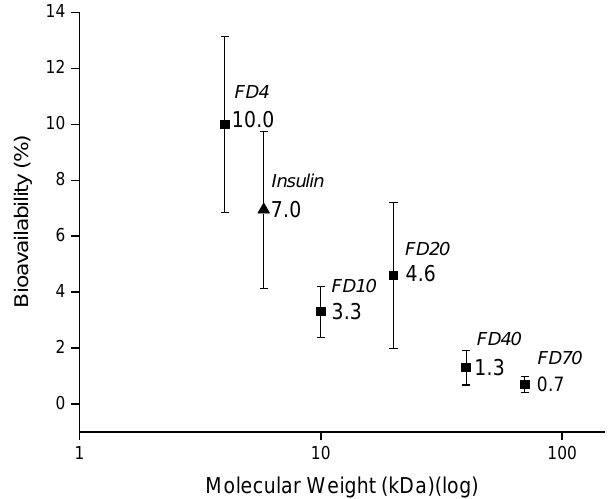
Figure 7. Comparison of the nasal bioavailabilities of FITC-labeled dextrans with different molecular weights and fitting insulin into the trend obtained with dextrans. Table 5. Pharmacokinetic parameters obtained for the various FITC-dextrans loaded SFDs. FD Formulation